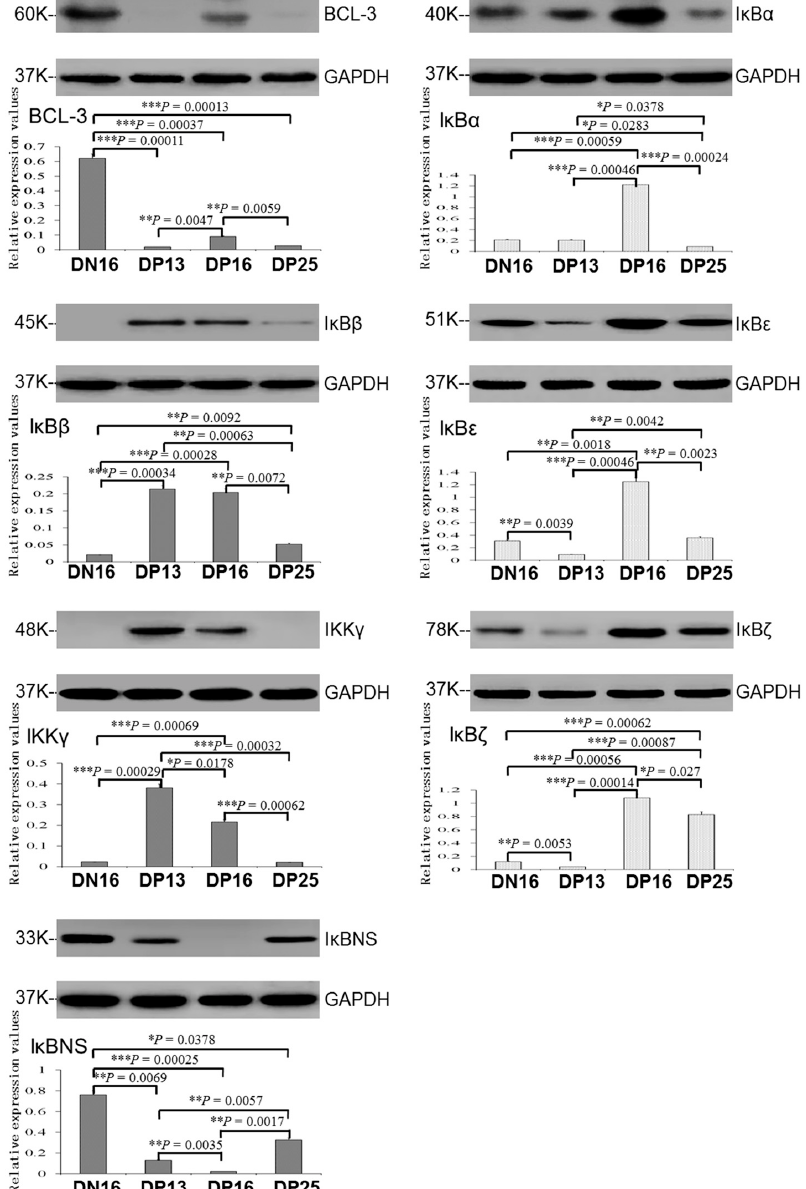
Figure 4. Expression of I κ B family proteins in lymph nodes from non-pregnant ewes and pregnant ewes. Note: DN16 = day 16 of the estrous cycle; DP13 = day 13 of pregnancy; DP16 = day 16 of pregnancy; DP25 = day 25 of pregnancy. Significant differences ( p < 0.05) are indicated by different letters within the same color column. P values between 0.01 and 0.05 are shown with one (*) asterisk, and P values between 0.001 and 0.01 are shown with two (**) asterisks, and P value less than 0.001 is designated with three (***) asterisks.